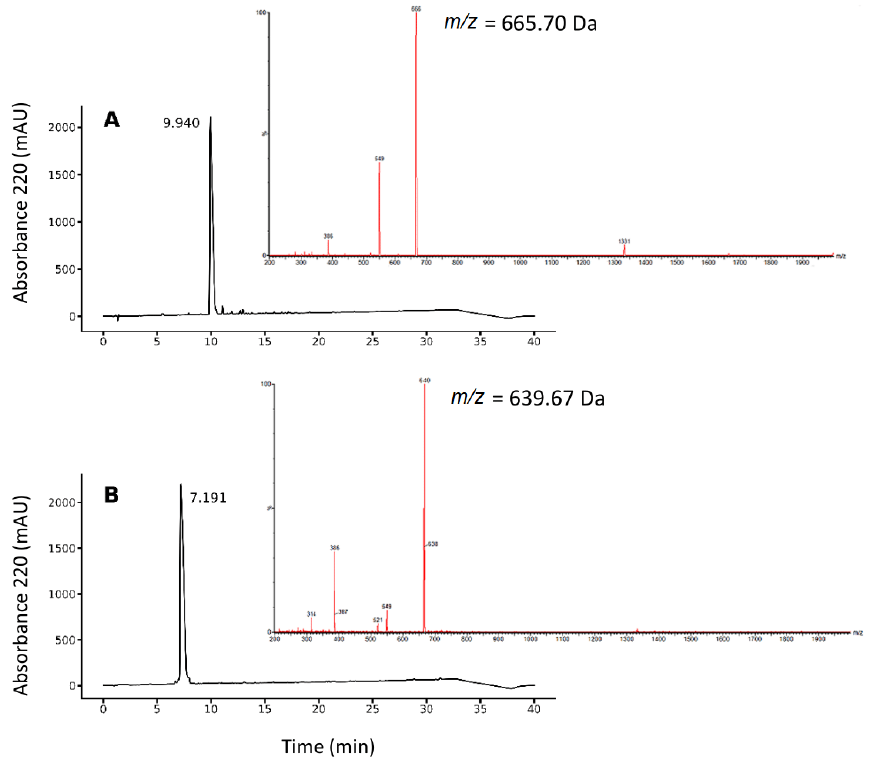
Figure 2. Chromatographic and mass spectrometric profiles for the RGD analogues ( A ) GRGDYV and ( B ) GRGDHV.